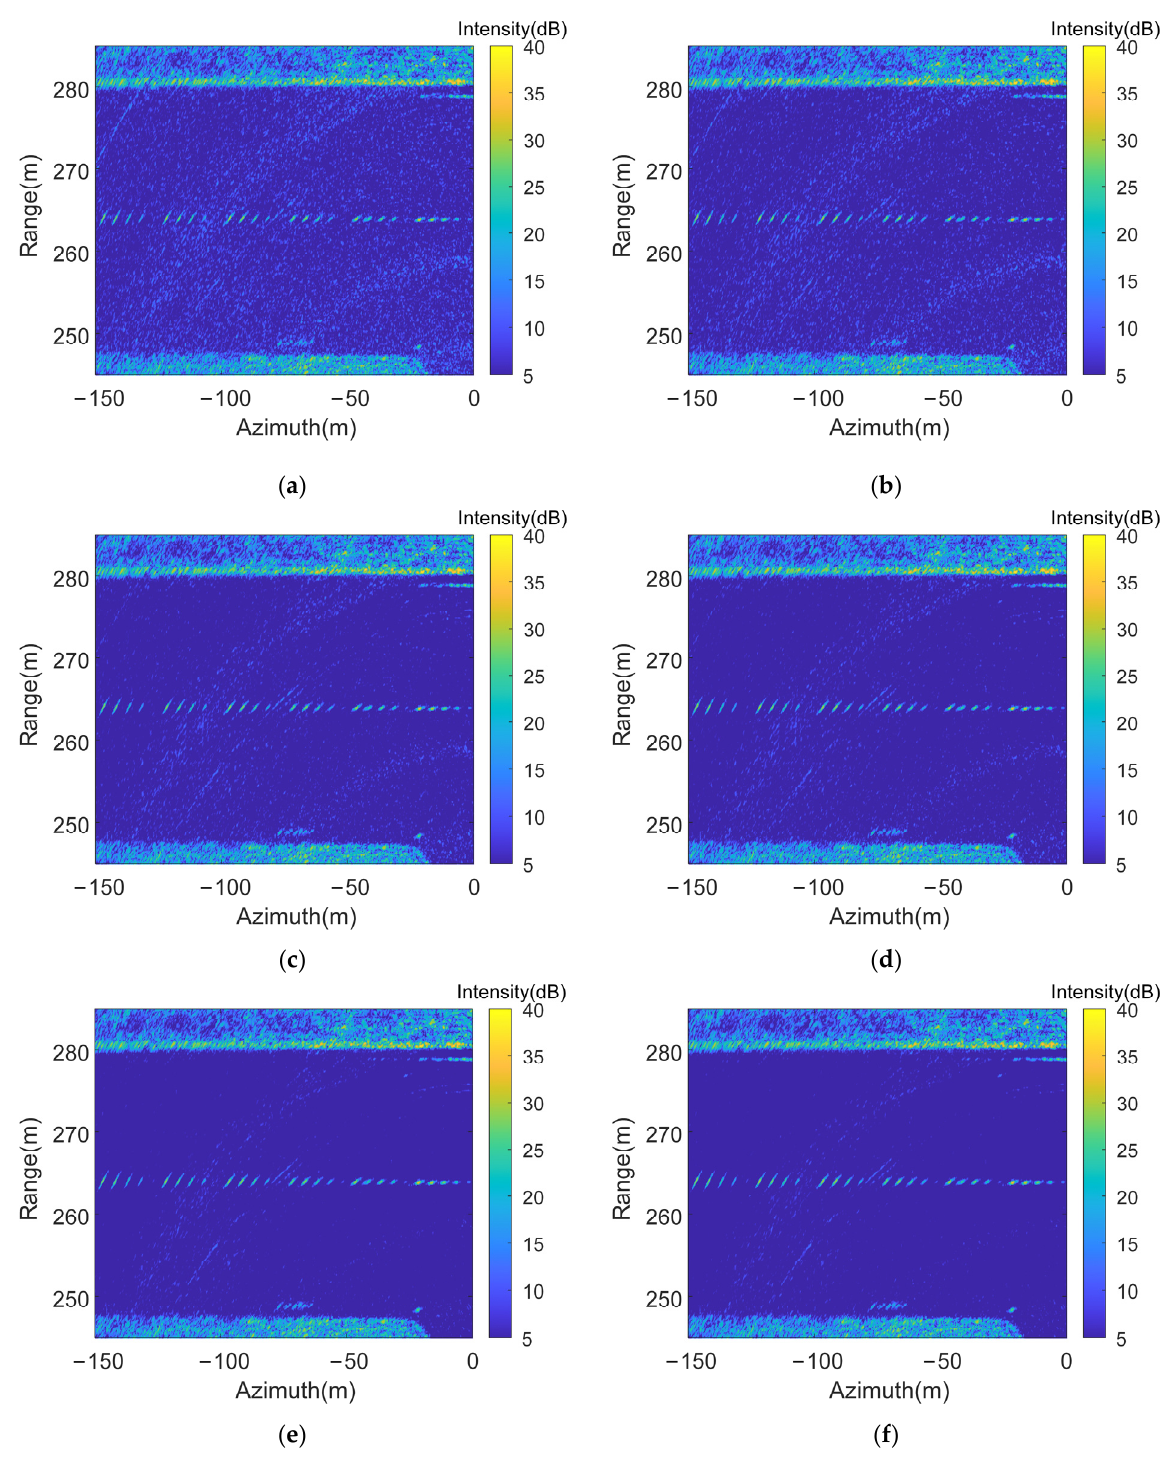
Figure 15. The comparison of coherent accumulation images: ( a ) using 4 images (uncorrected); ( b ) using 4 images (corrected). ( c ) using 8 images (uncorrected); ( d ) using 8 images (corrected). ( e ) using 16 images (uncorrected); ( f ) using 16 images